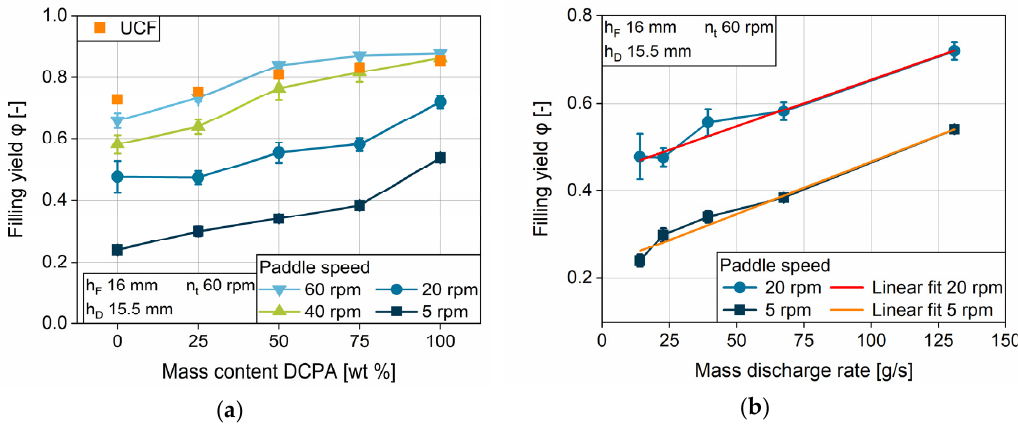
Figure 17. Impact of the mass content of DCPA on the filling yield ( a ), and correlation of the mass discharge rate from a hopper (25 mm orifice, Figure 5a) with the filling yield of the corresponding formulations at paddle speeds of 5 and 20 rpm ( b ).